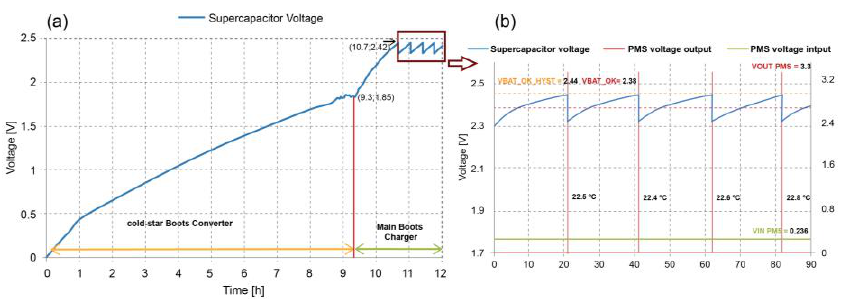
Figure 7. ( a ) Supercapacitor voltage behavior from cold start mode to transmission mode and temperature measured by the system. ( b ) Inset magnification of the supercapacitor’s charging and discharging cycle in the sensor node transmission stages. Table 3. Values of energy stored in the supercapacitor and power supplied by the